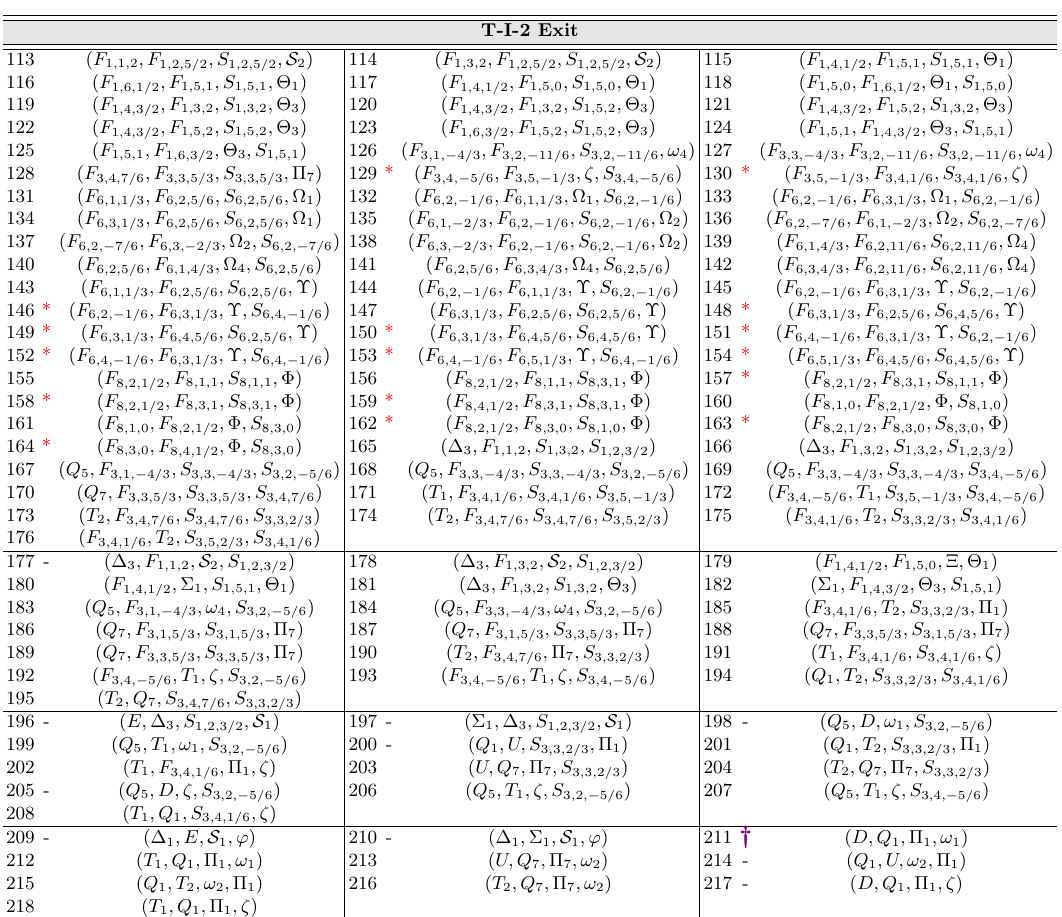
Table 2: TI-2 models with scalar and fermionic exits: The model Table 6 . T-I-2 models with scalar and fermionic exits: the model † unifies at a scale of m G ’ 10 17